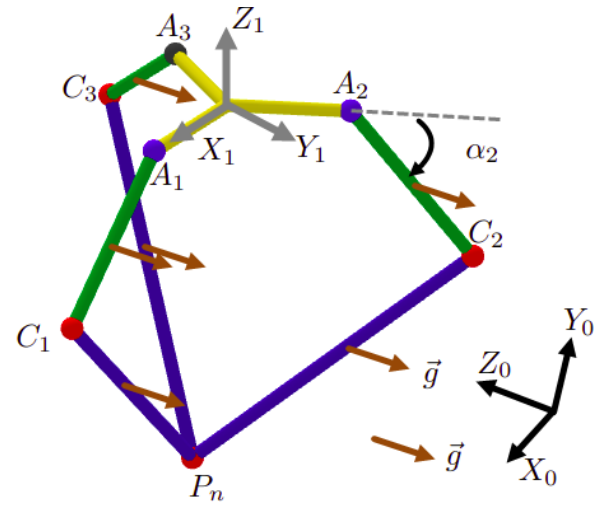
Figure 18. The gravity with respect to the Delta